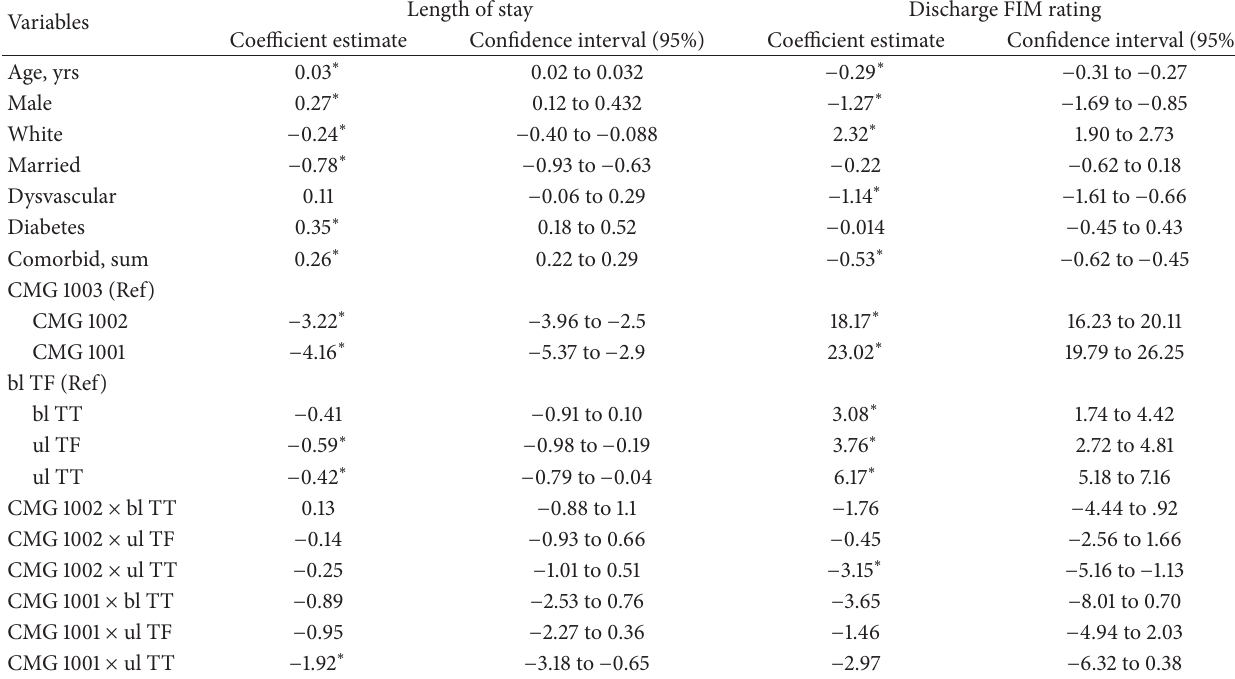
Table 2: Coefficient estimates from multiple linear regression models: predictors for length of stay and discharge FIM rating, source UDSMR